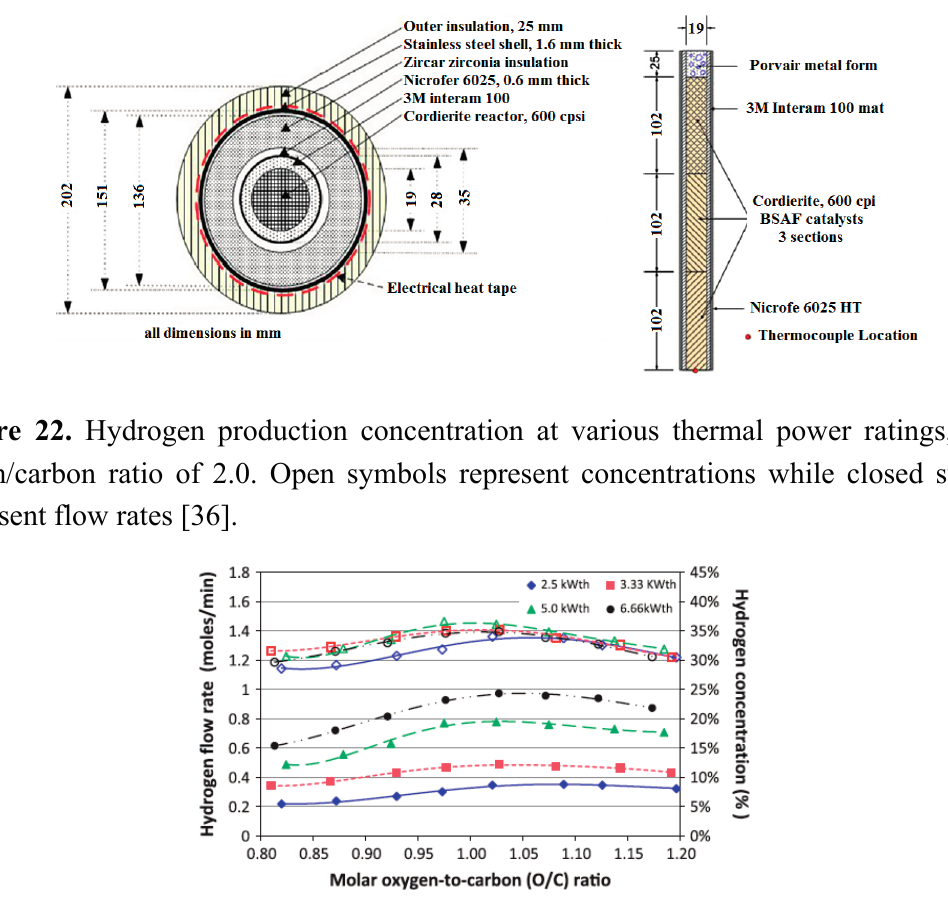
Figure 21. Reactor vessel with cross-sectional ( a ) and longitudinal ( b ) view [36].